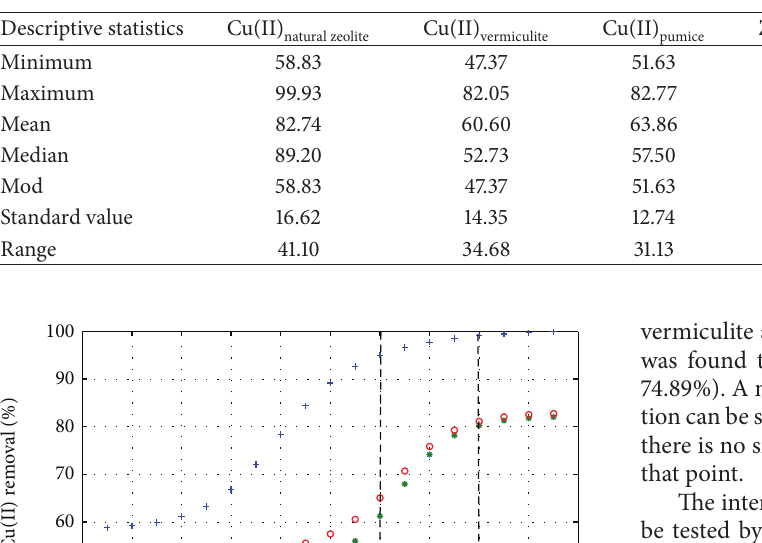
Table 4: Basic statistics for interpolated ANN outputs.